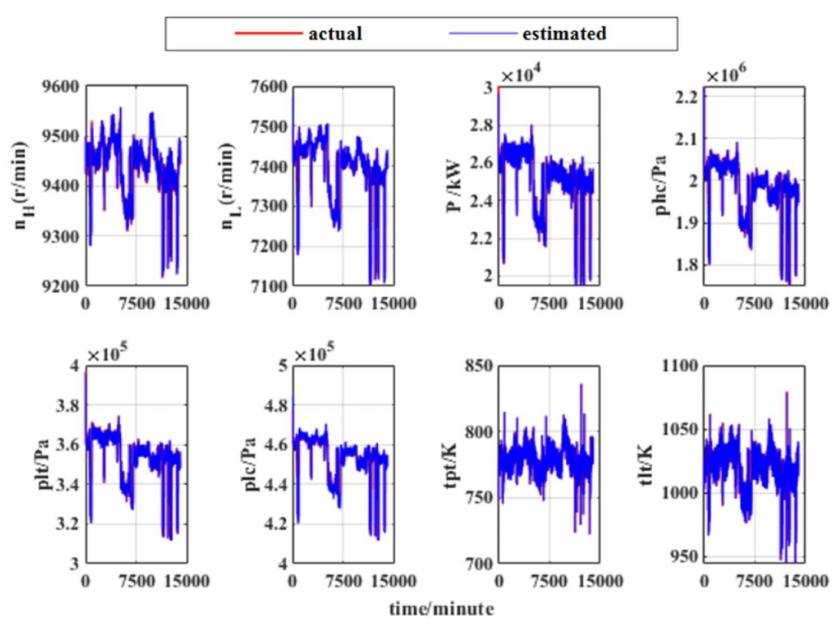
Figure 10. Actual data versus estimated data in training set.